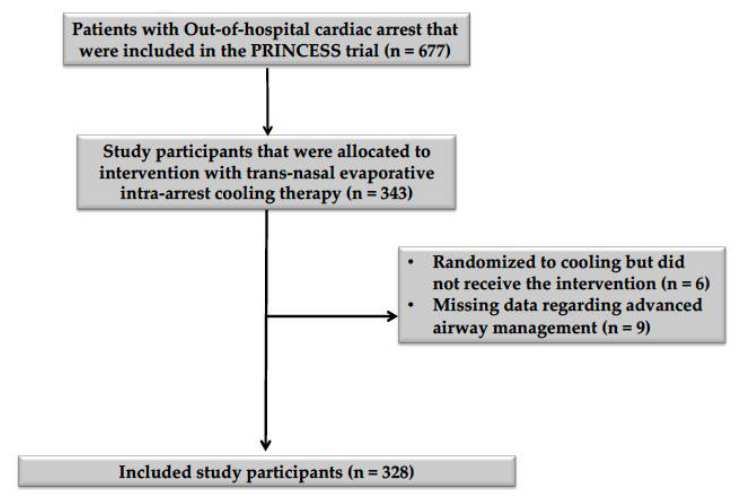
Figure 1. Flowchart describing patient inclusion and exclusion. A diagram describing the inclusion and exclusion of study participants, according to the inclusion and exclusion criteria mentioned in the methodology section of this article. Table 1. Demographics before and after propensity score matching. Data after propensity score matching corresponded to that of one of the five imputed datasets that were generated following multiple imputation by chained equations (mice). Abbreviations: BMI = body mass index, CPR =